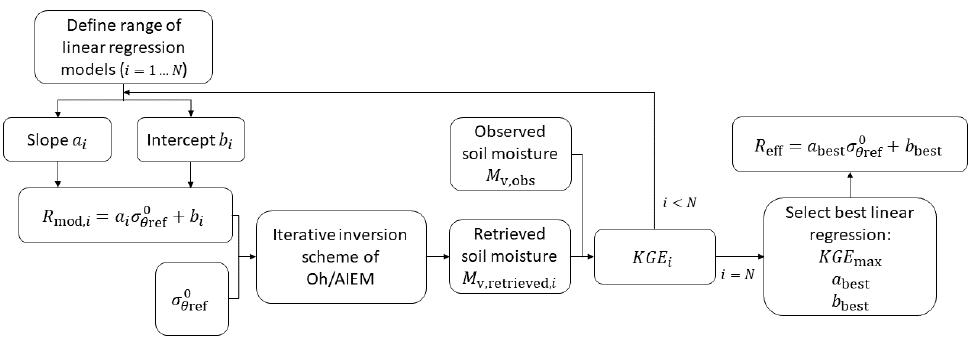
Figure 3. Graphical overview of the effective roughness modeling